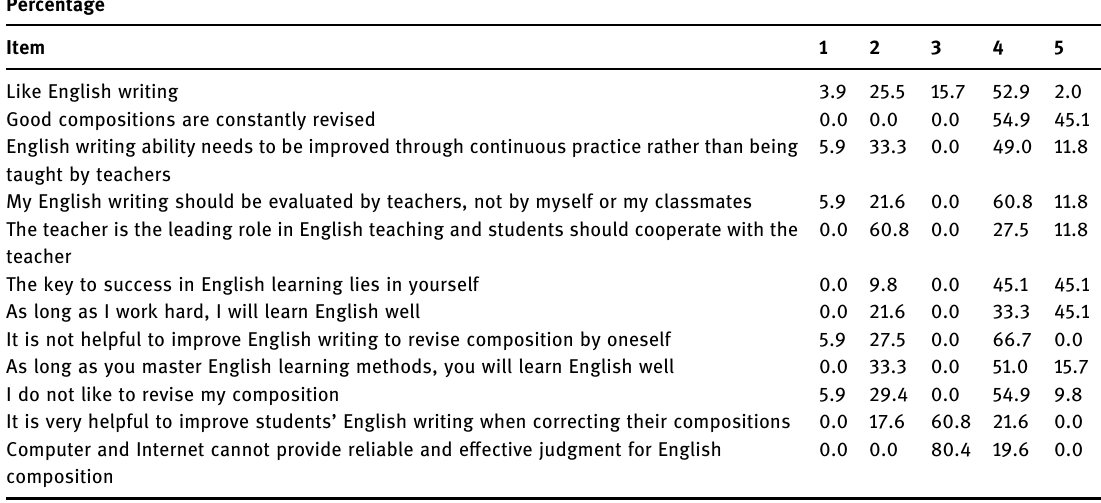
Table 5: Students ’ understanding of English writing before the experiment